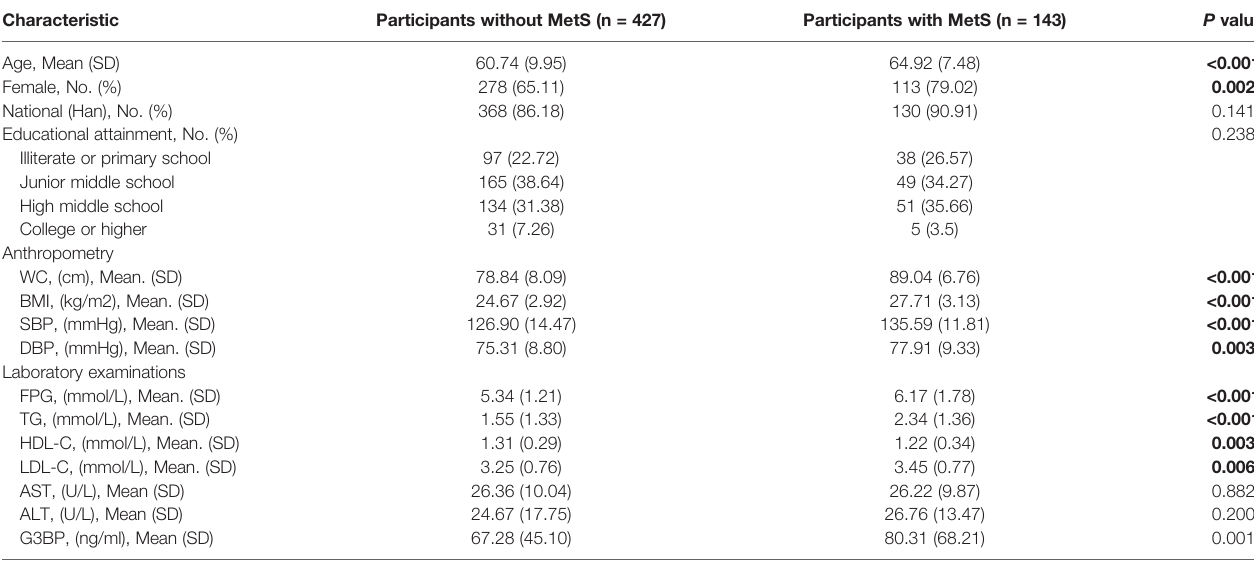
TABLE 1 | Characteristics of study participants with and without